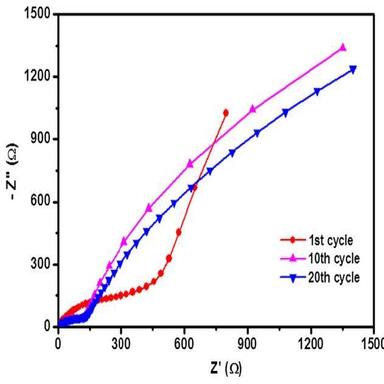
EIS spectra of the SVF composite electrode.